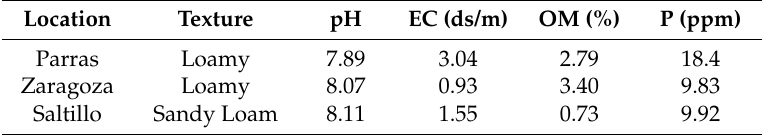
Table 1. Analysis of soil from three locations in Coahuila.